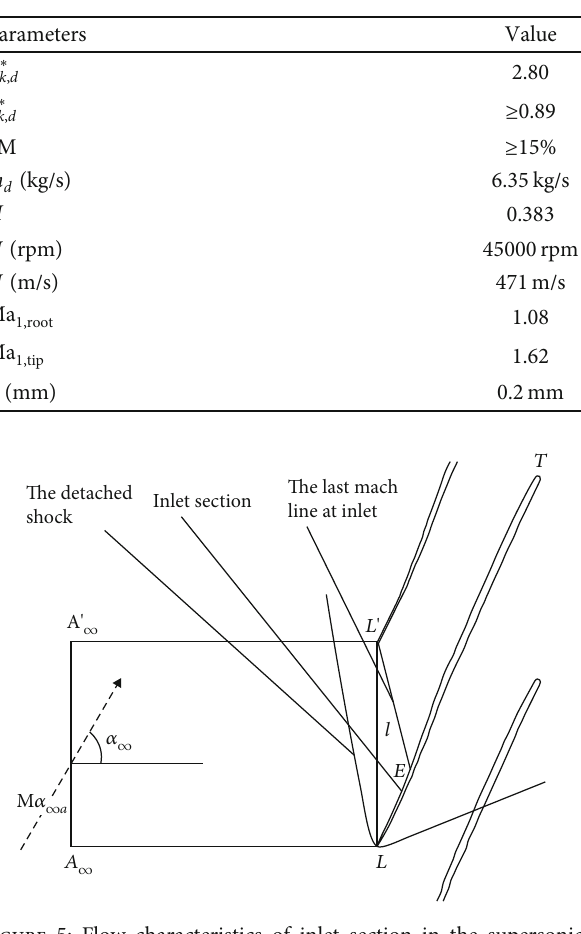
Table 2: Variable range for 2D pro fi le optimizations.